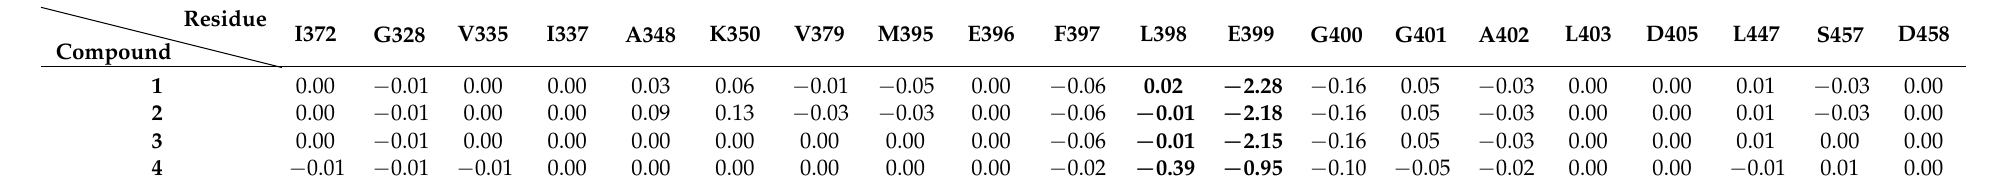
Table 4. Charge transfer energies (E ct ) calculated at the FMO-DFTB3/3OB-3-1 level. The Charge transfer energies (E ct ) of the hinge regions, L398 and E399, are shown in